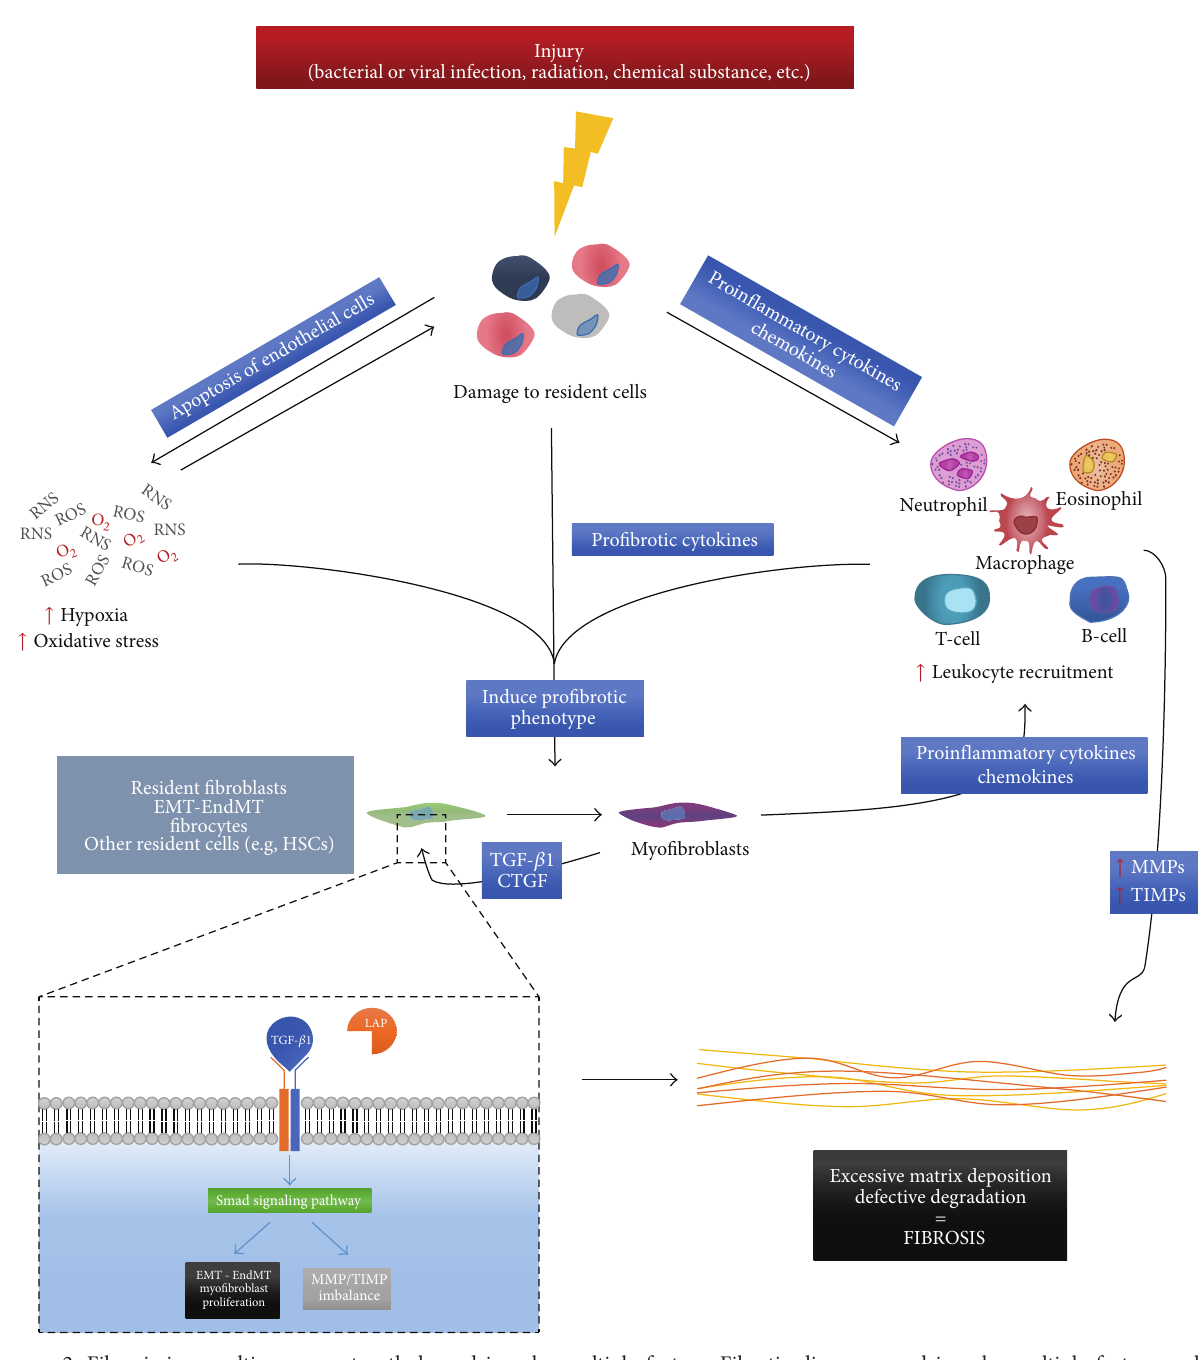
Figure 2: Fibrosis is a multicomponent pathology driven by multiple factors. Fibrotic diseases are driven by multiple factors such as inflammatory reaction, hypoxia, and oxidative stress leading to the activation of the TGF- 𝛽 1 pathway (DC: dendritic cell, EMT: epithelial- to-mesenchymal transition, LAP: latency associated protein, MMP: matrix metalloproteinase, RNS: reactive nitrogen species, ROS: reactive oxygen species, Smad: small mothers against decapentaplegic homolog, TGF: transforming growth factor, and TIMP: tissue inhibitor of